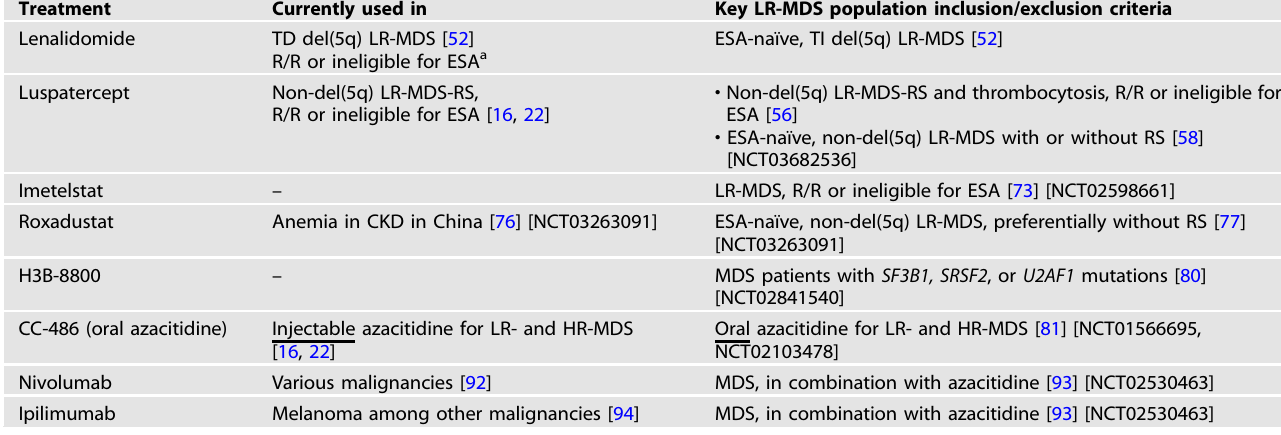
According to ELN guidelines. Abbreviations: CKD chronic kidney disease, ELN European LeukemiaNet, ESA erythropoiesis-stimulating agent, HR-MDS higher-risk MDS, LR-MDS lower-risk MDS, LR-MDS-RS lower-risk MDS with ring sideroblasts, MDS myelodysplastic syndromes, R/R relapsed/refractory, RS ring sideroblasts, TD transfusion dependent, TI transfusion